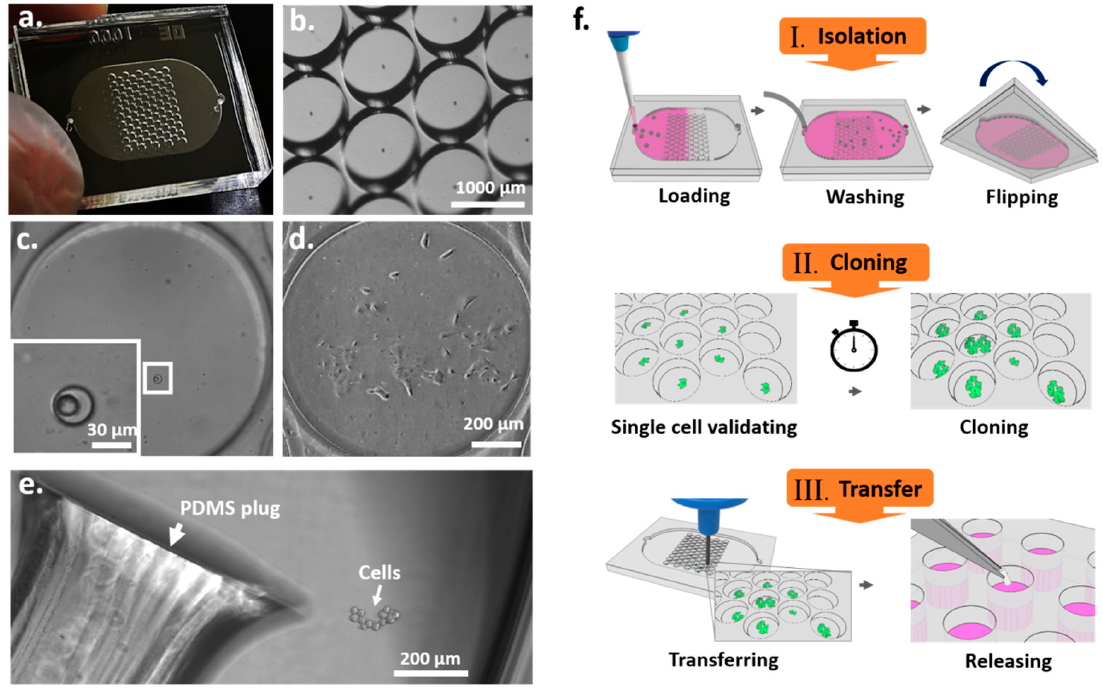
Figure 1. Microfluidic device for single-cell cloning (SCC). ( a ) Image of the pair-wells device for single-cell trapping and cloning. ( b ) Image of the clone wells and trap wells of the device taken under a dissecting microscope. ( c ) The inset image shows an enlargement of a trap well within a single cell. ( d ) A single-cell-derived clone proliferated in the clone well after nine days. ( e ) The cell colony was then released from the SCC device by punching the PDMS surface. The PDMS plug was collected and transferred to a 96-well plate for further cell proliferation. ( f ) Schematic diagram of the principal operation of the SCC device. There are three significant steps for establishing monoclonal cell lines: single-cell isolation, cloning, and transfer.